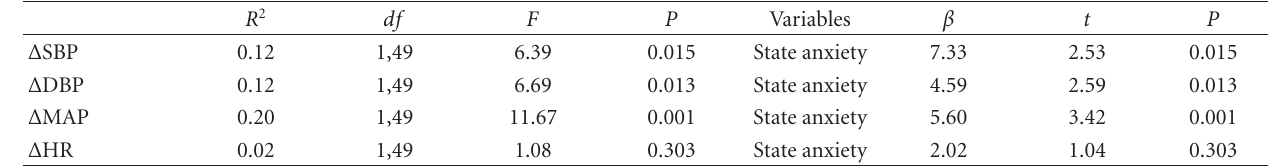
Table 4: Parsimonious linear regression models for cardiovascular reactivity to anger